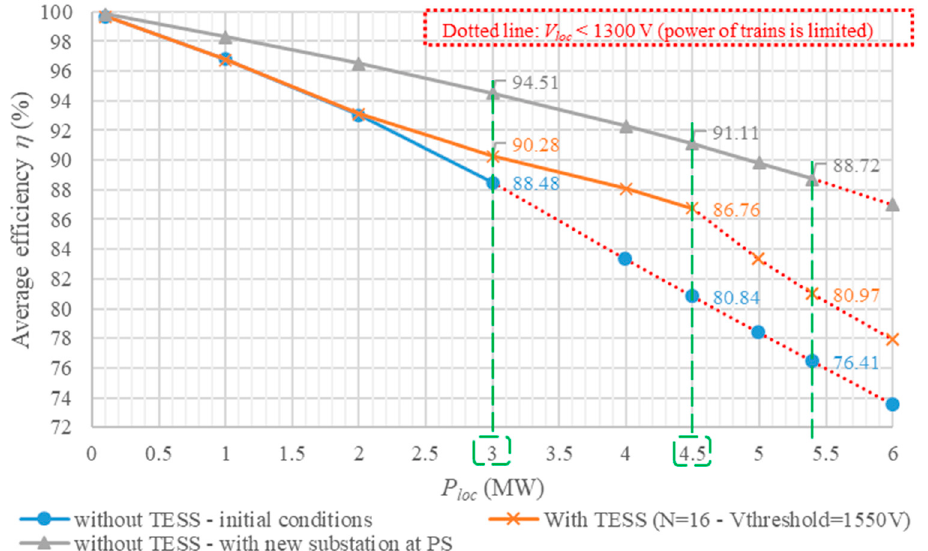
Figure 14. E ffi ciency according to the power of the trains: initial conditions, with TESS ( N = 16 - V threshold = 1550 V) or with a new substation ( E 0 = 1750 V; R int = 25 m Ω ), implemented at PS. V threshold = 1550 V) or with a new substation ( E 0 = 1750 V; R int = 25 m